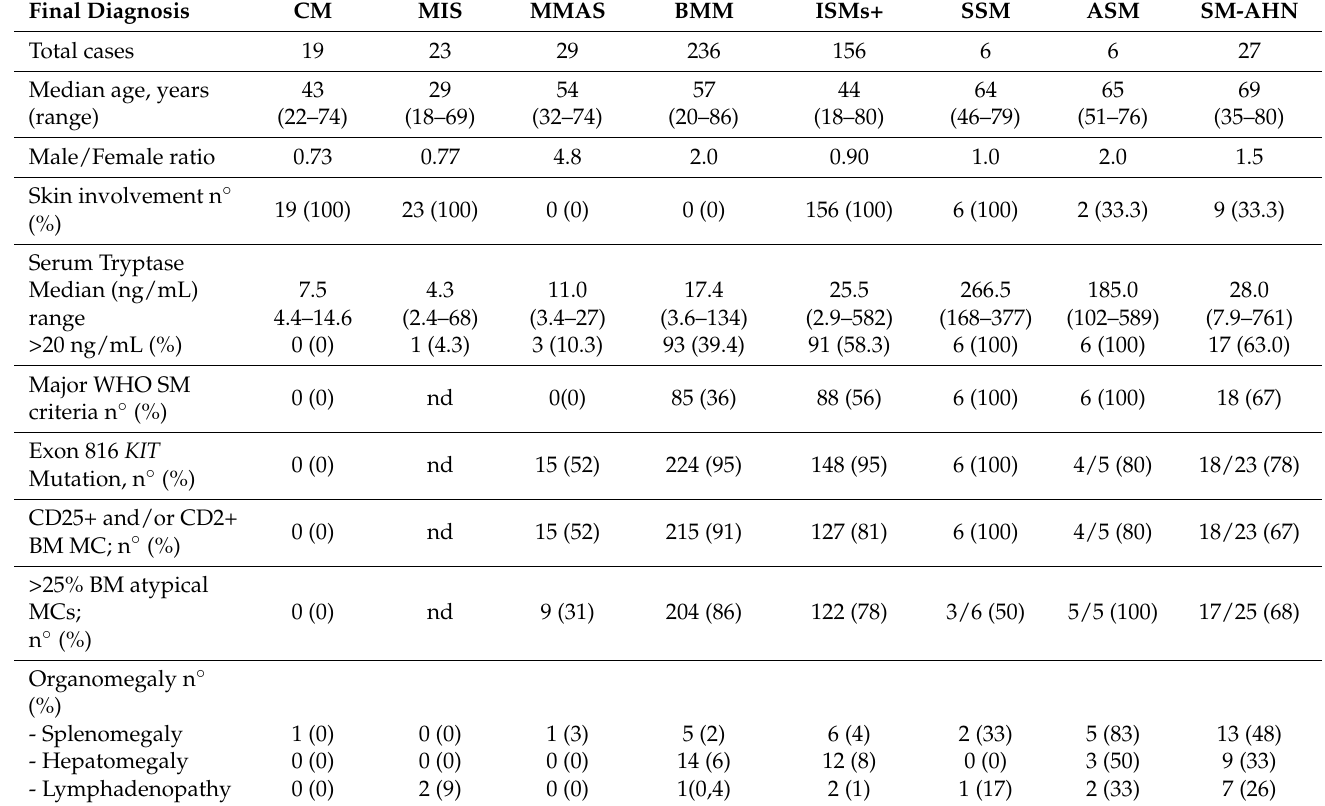
Table 2. Characteristics of patients with clonal mast cell